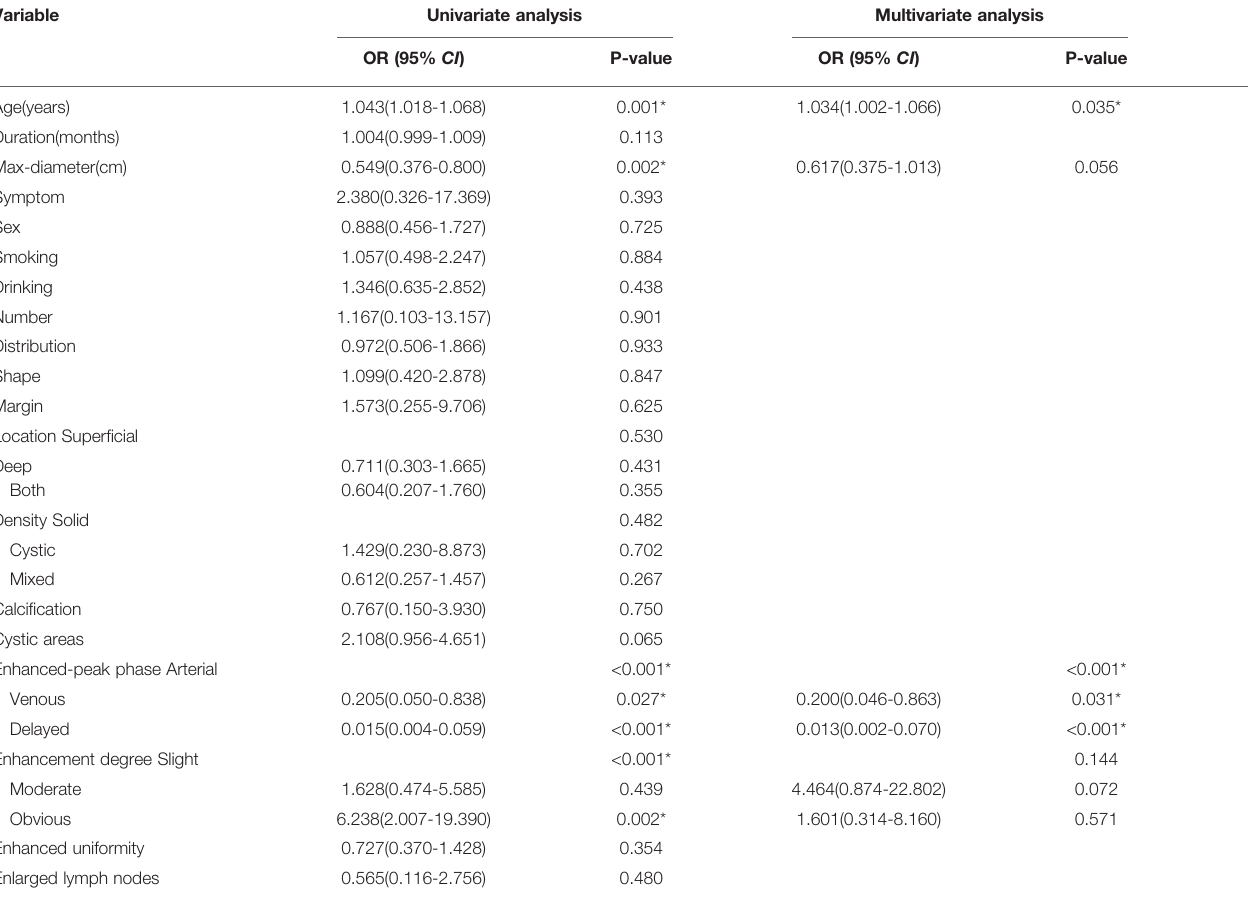
TABLE 4 | Univariate and Multivariable logistic regression analysis for selecting clinical features of model